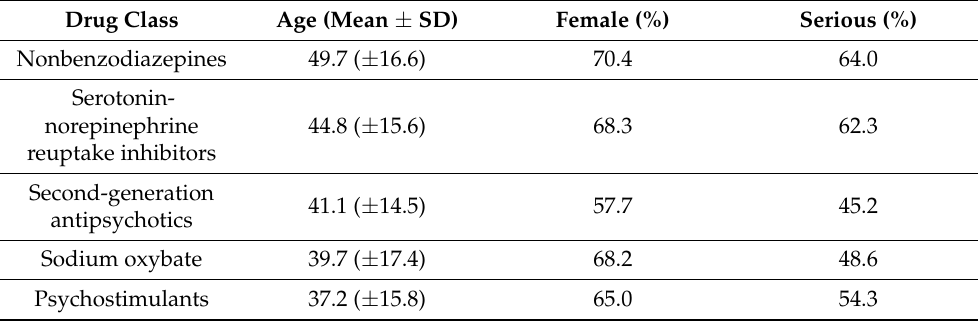
Table 2. Characteristics of the reports of patients with sleep-related eating disorder (SRED) according to drug